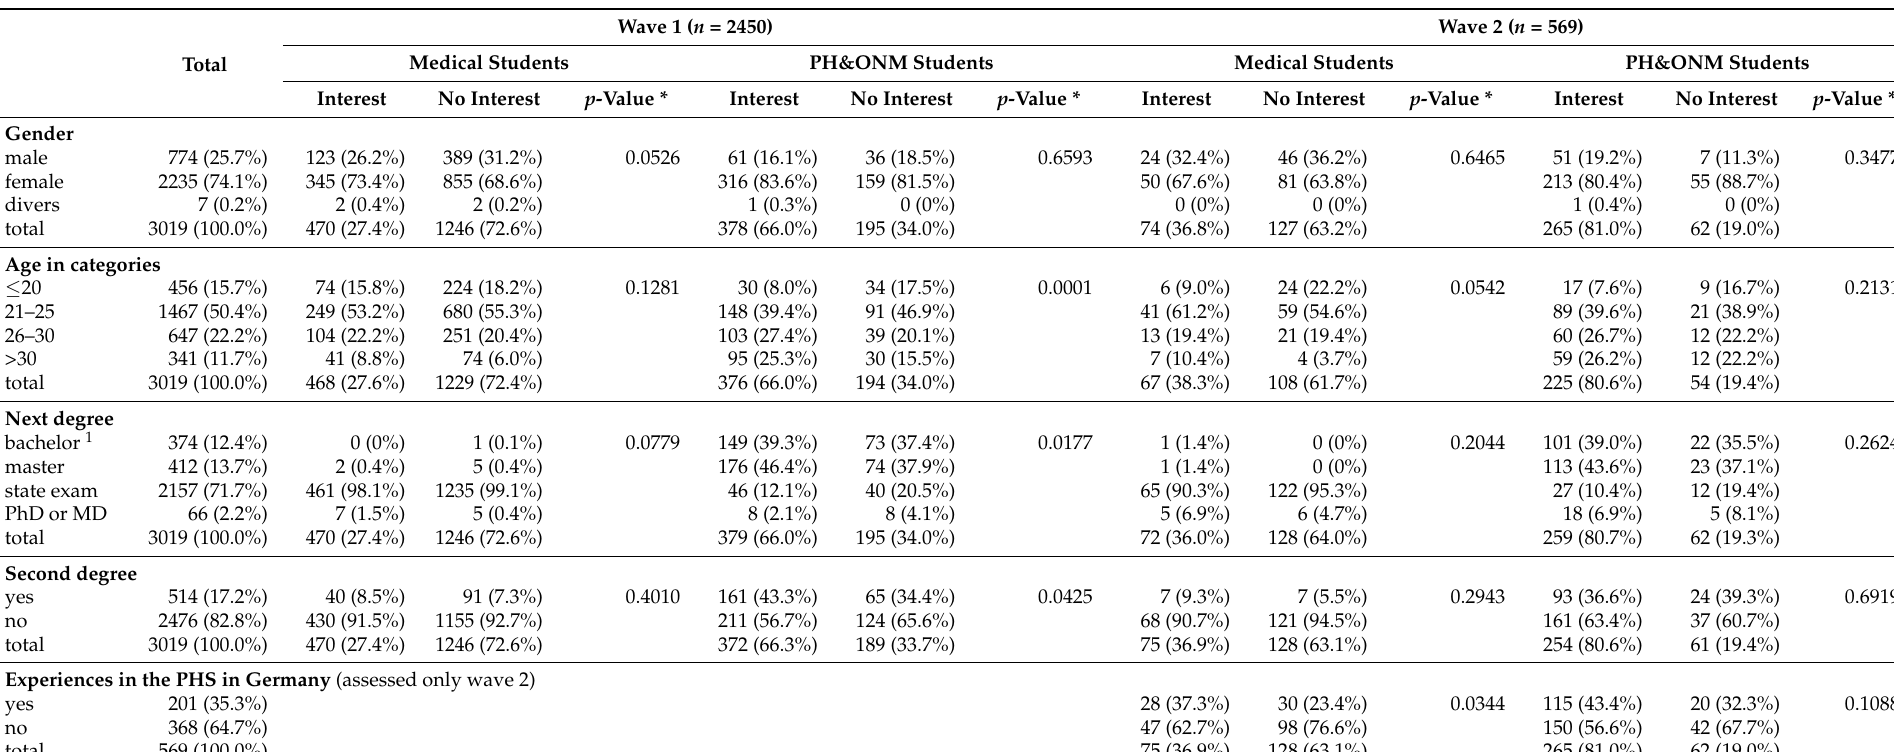
Table 1. Characteristics of the study participants ( n = 3019) in wave 1 and 2 and separated for medical students ( n = 2058) and public health and other